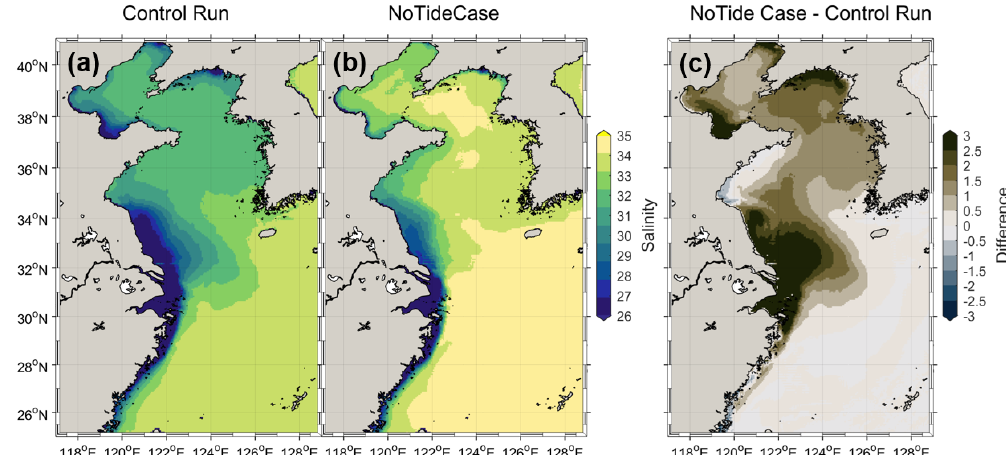
Figure 6. The annually and vertically averaged salinity of the shelf water for the control run (a) , no-tide case (b) , and their difference (c) . Positive (negative) values denote the salinity of the no-tide case as being higher (lower) than that of the control run.